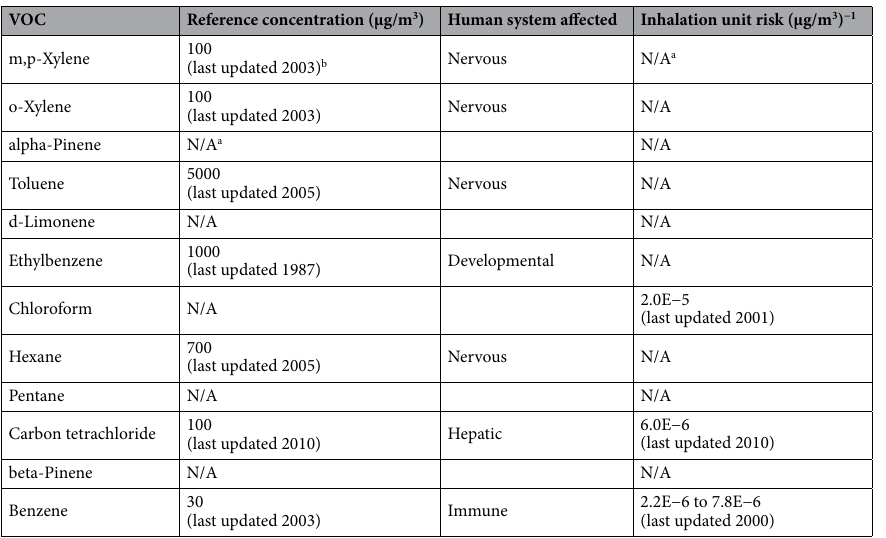
Table 4. Indoor air VOCs passing the K–S test that were used for probabilistic risk analysis. Reference concentrations for non-cancer assessments and inhalation unit risks for cancer assessment are provided where available in the Integrated Risk Information System (EPA). For VOCs with an established reference concentration, the human organ or physiological system affected is included. a N/A-not available in IRIS. b Indicates the year in which risk information was last updated by the USEPA.